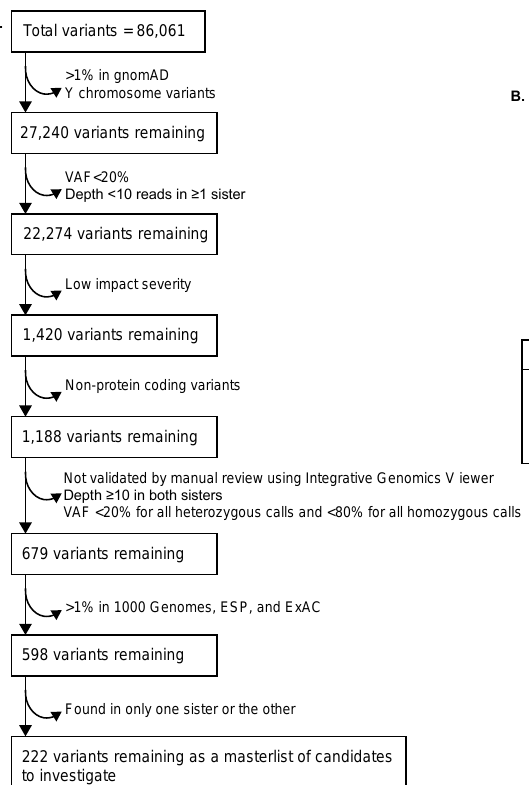
Figure 1. Criteria used for filtering and prioritizing variants identified across the genetic landscape of sisters from family F1528. ( A ) Filtering strategy to identify genetic landscape variants; ( B ) pri- oritization of variants to identify those most likely to exert an effect on the encoded protein; and ( C ) characterization of variants most likely to affect protein function using various characteristics